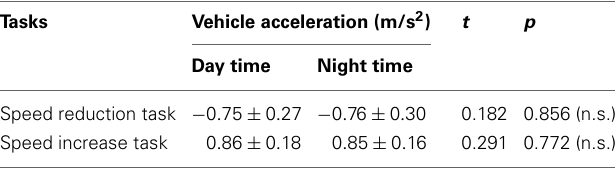
Table 1 | Average vehicle